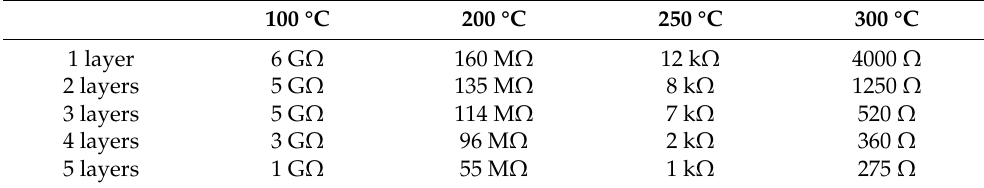
Figure 3. ( a ) XRD diffraction pattern of indium oxide obtained from aqueous nitrate precursors. Films obtained at 300 °C had characteristic peaks of indium oxide and did not show any unwanted peaks. ( b ) Variation in graphene sheet resistance with layer thickness showed inverse proportionality. as used for resistance dependance measurement. Table 1. Sheet resistance for one to five layers of graphene ink printed and annealed at different temperatures. Each layer was 100 nm